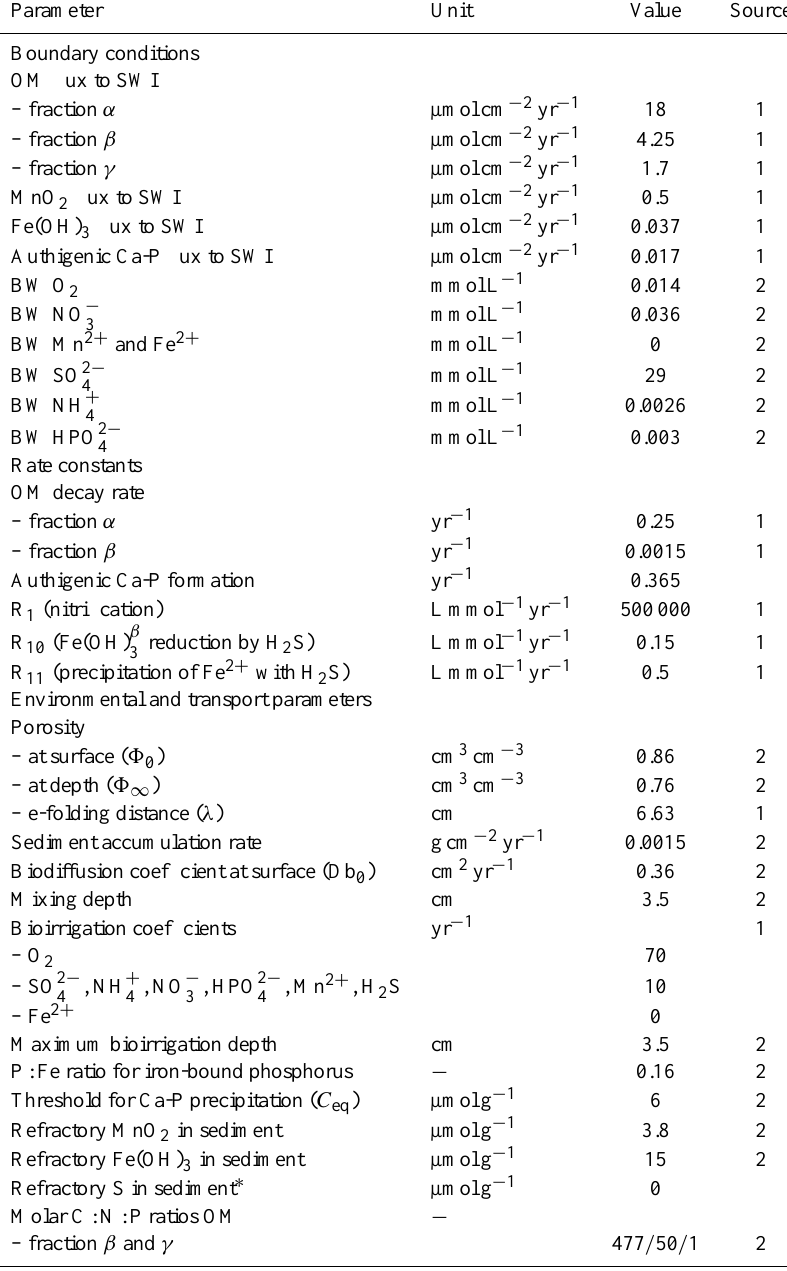
Table 6. Changed model parameters compared to Reed et al.